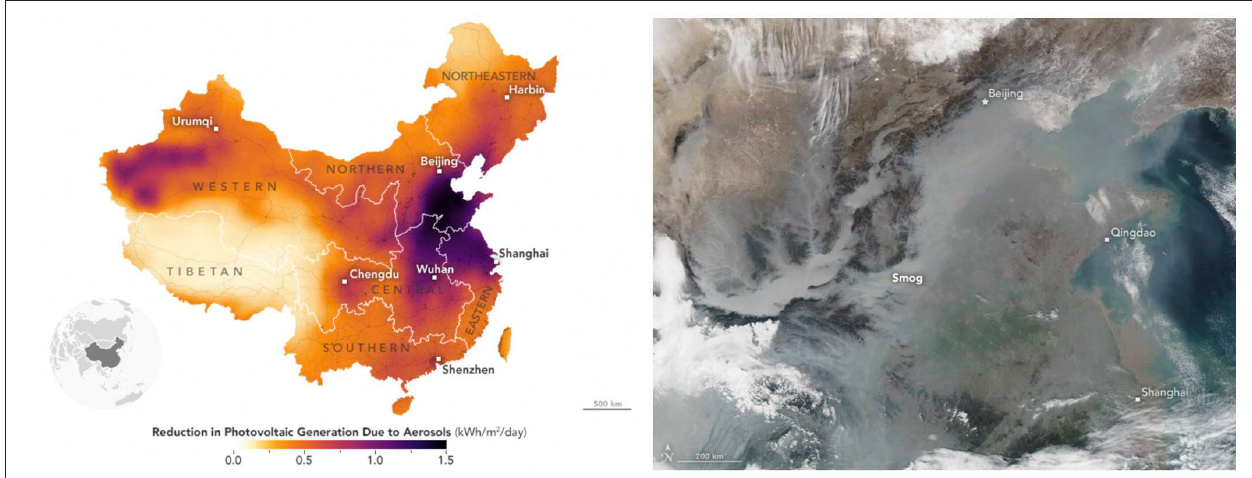
FIGURE 2 | (L) Impact of aerosols on the average amount of radiation reaching the land surface of China between 2003 and 2014 [Credit: Joshua Stevens, NASA Earth Observatory, using data from Li et al. (2017)]. (R) Natural-color image of haze over eastern China from the Visible Infrared Imaging Radiometer Suite (VIIRS) on the Suomi National Polar-orbiting Partnership (NPP) satellite on January 25, 2017. (Credit: Jeff Schmaltz, NASA, LANCE/EOSDIS).